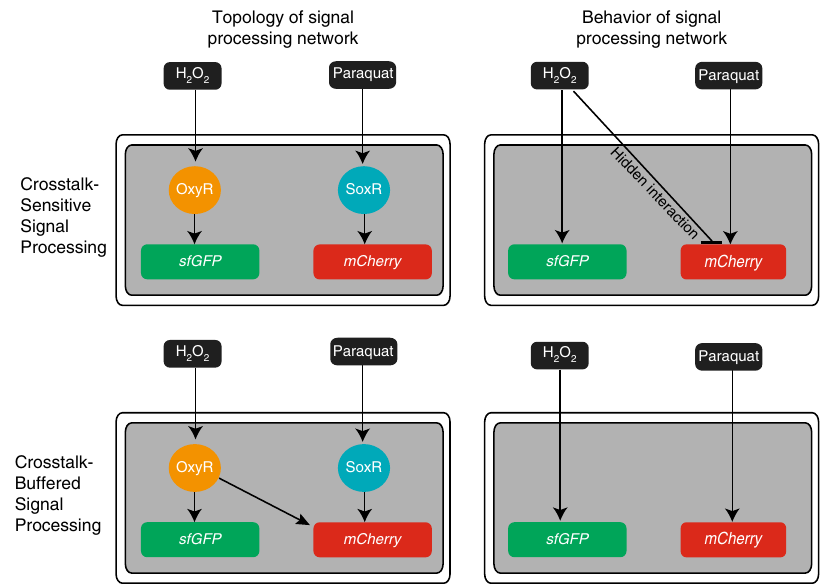
Fig. 4 The topology of signal-processing networks as perceived from transcription factor-DNA interactions (left column) is contrasted with the actual behavior of these networks (right column). The top row illustrates an example of crosstalk due to a hidden interaction between the inputs and the network. The bottom row illustrates how crosstalk between inputs and the network can be buffered by to crosstalk-compensating